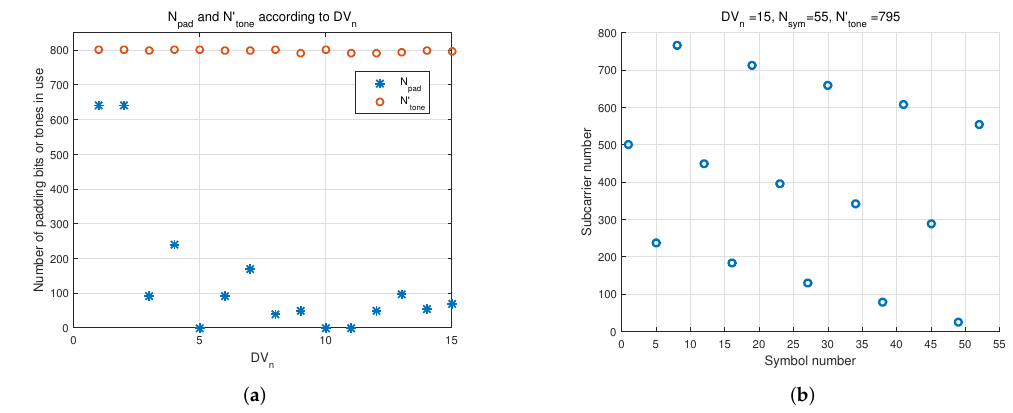
Figure 5. Diversity mapper: ( a ) number of padding bits and tones in use; and ( b ) locations of the copied bits.